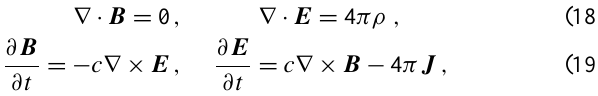
Fig. 5. Normalized magnetic field energy spectrum ε for τ = 250 (solid), τ = 500 (dashed), τ = 750 (dotted) and τ = 1000 (dot dashed). It is observed that as time advances, there is an emergence of waves at higher modes than what was originally available. (a) ε as a function of the wave number y . (b) ε as a function of the fre- quency x